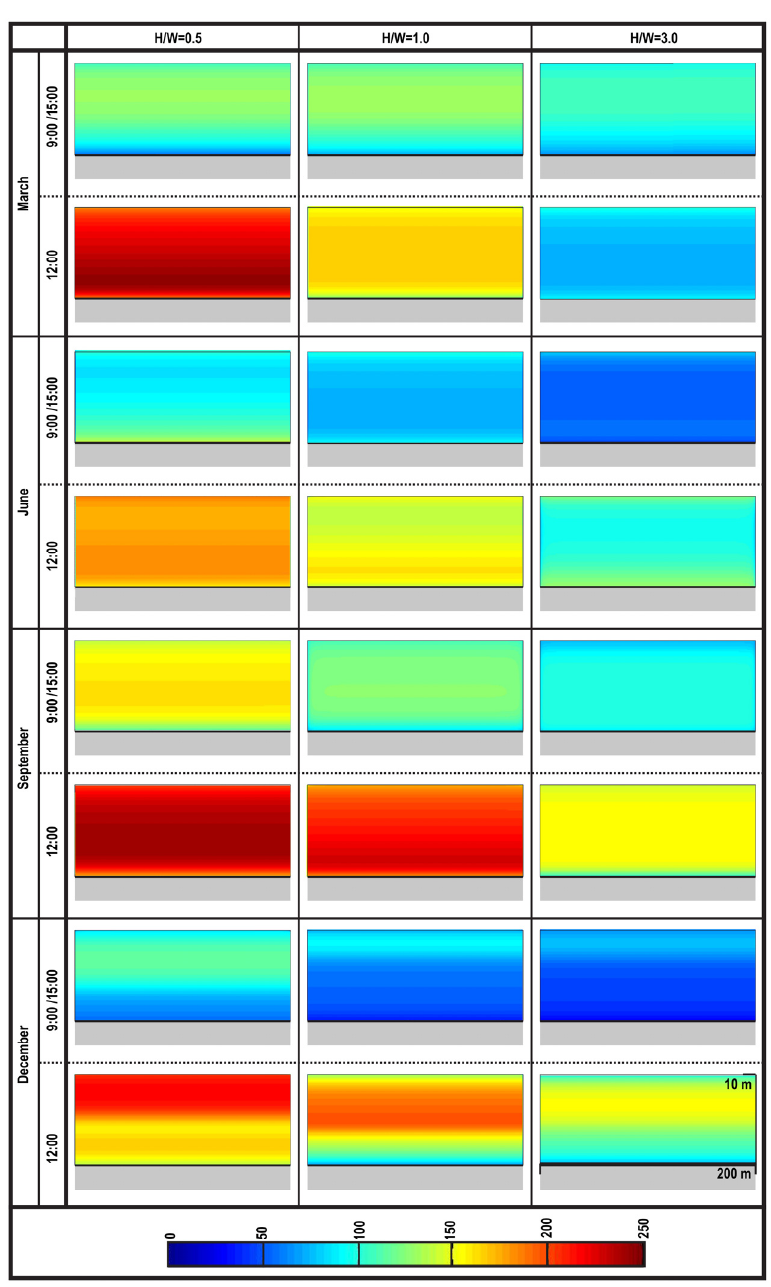
Figure 13. Parametric analysis for different widths of street canyons. South façade, Seville. (W/m 2 ) From each of these simulations, data has been extracted for point situated in a height of H = 2.00 m, H = 5.00 m and H = 8.00 m, which would correspond to the ground, first and second floor of a building located within the simulated street canyon.